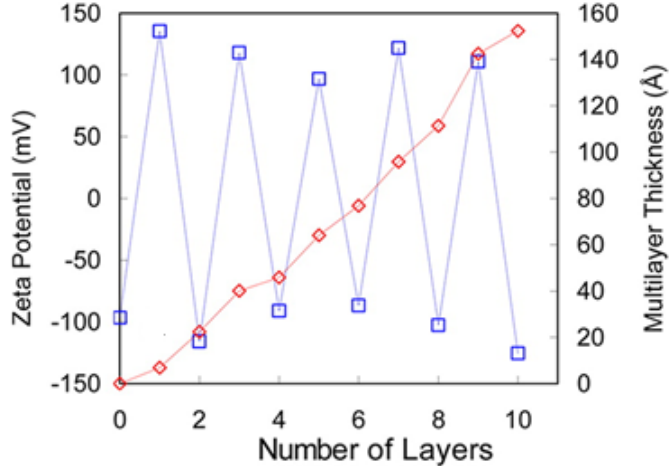
Figure 2. Change of the ξ potential (blue symbols) and multilayer thickness (red symbols) with the alternate deposition of poly(diallyldimethylammonium chloride (PDADMAC) and poly(4-styrenesulfonate of sodium) (PSS) layers onto silicon wafers from polyelectrolyte solutions with concentration 10 mM, and ionic strength fixed in 100 mM. Reprinted from reference [139], Copyright (2014), with permission from the American Chemical Society.